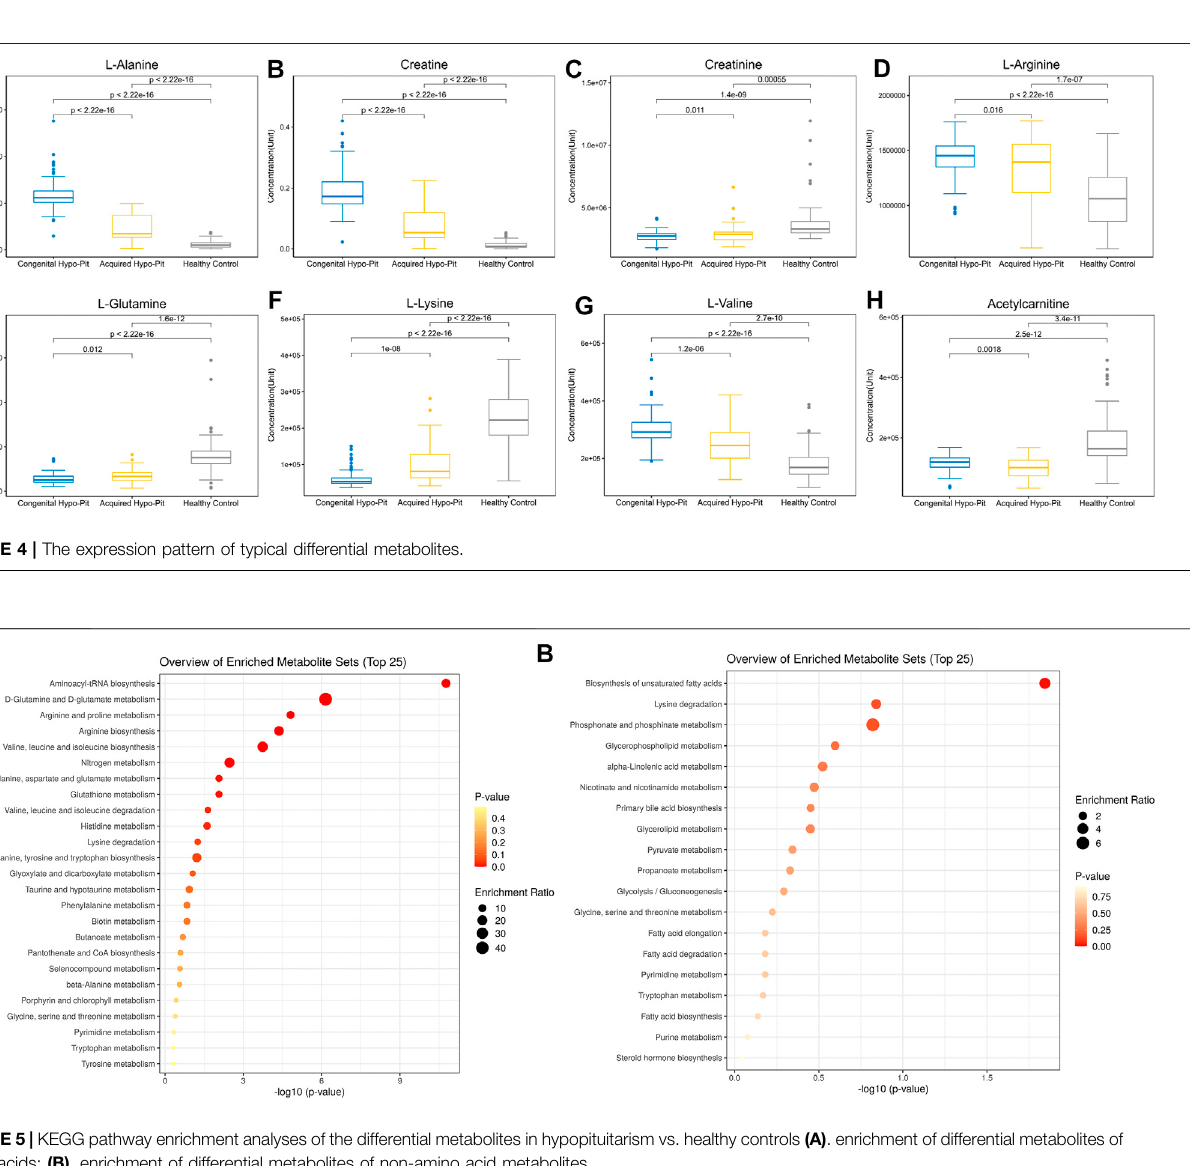
Frontiers in Pharmacology |